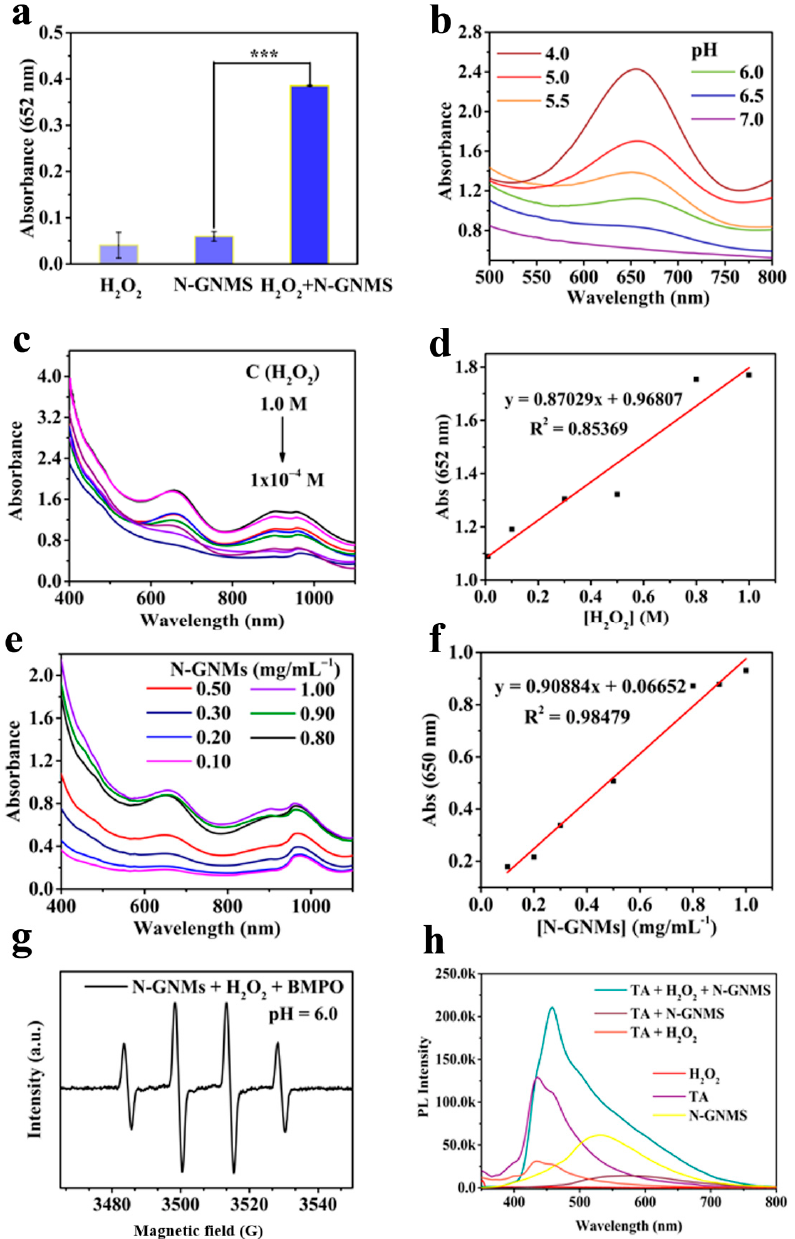
Figure 4. In vitro peroxidase (POD)-like catalytic activity of N-GNMs. ( a ) Catalytic oxidation of 5.0 mM TMB; absorption data for 1.0 M H 2 O 2 , 1 mg/mL − 1 N-GNMs and 1.0 M H 2 O 2 with 1 mg/mL − 1 N-GNMs (*** p < 0.001, two-tailed t test); ( b ) pH-sensitive POD-like catalytic activity of 1 mg/mL − 1 N-GNMs; ( c ) Absorbance spectra of the N-GNMs after the addition of different concentrations of H 2 O 2 (1 × 10 − 4 , 1 × 10 − 3 , 0.01, 0.10, 0.30, 0.50, 0.80, 1.0 M H 2 O 2 and 1.0 mg/mL − 1 N-GNMs); ( d ) Linear calibration plot for the POD-like catalytic reaction of N-GNMs for H 2 O 2 detection; ( e ) Absorbance spectra of the N-GNMs after the addition of different concentrations of N-GNMs (0.10, 0.20, 0.30, 0.50, 0.80, 0.90, 1.0 mg/mL − 1 N-GNMs and 1.0 M H 2 O 2 ); ( f ) Linear calibration plot for the N- GNM POD-like catalytic reaction for N-GNM detection; ( g ) Spin-trapped electron spin resonance (ESR) spectrum of • OH radicals in the H 2 O 2 /BMPO system with N-GNMs. ( h ) Fluorescence spectra of the phosphate buffered saline (PBS) solution (pH = 6.0, 10 mM) with TA, H 2 O 2 , N-GNMs, N-GNMs + TA, H 2 O 2 + TA, TA + N-GNMs + H 2 O 2